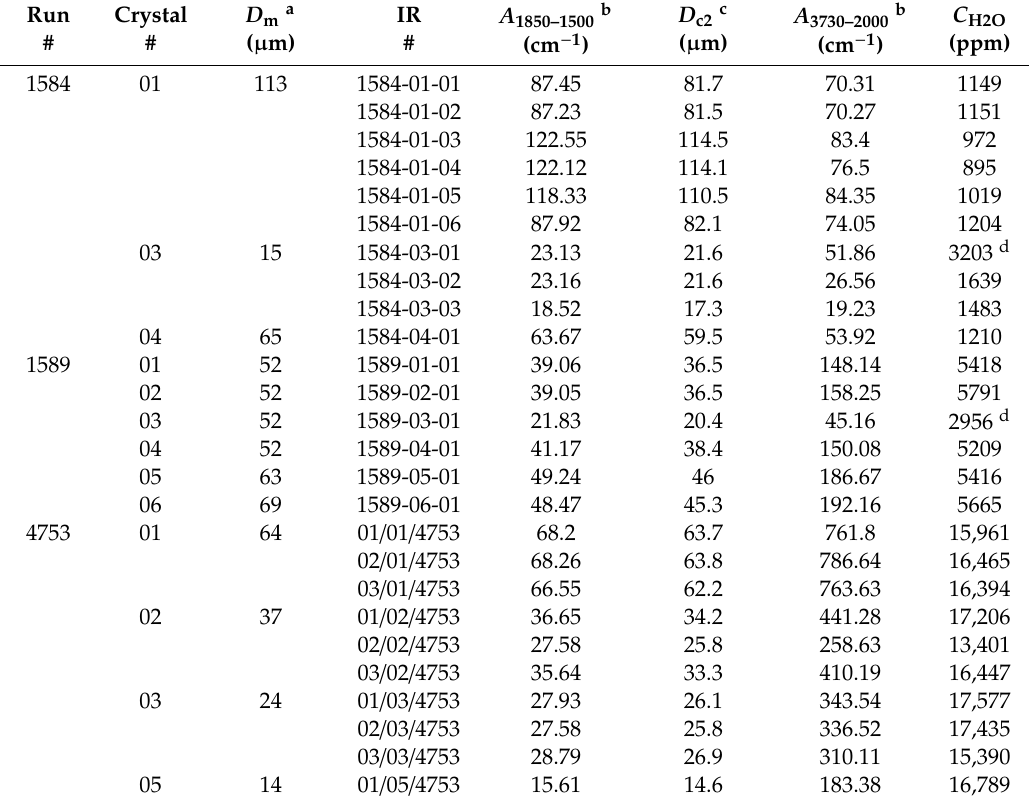
Table 1. Ambient unpolarized IR experiments performed on doubly-polished thin sections of low-H 2